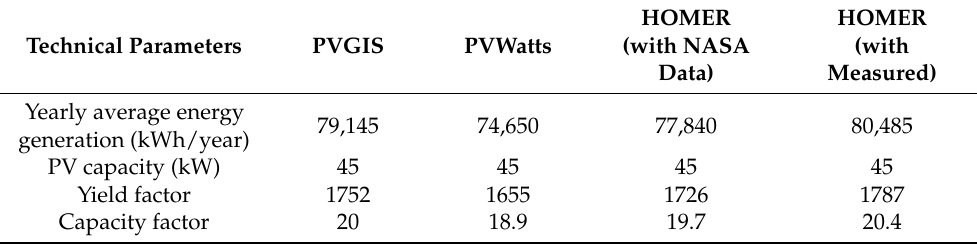
Table 11. Comparison of technical